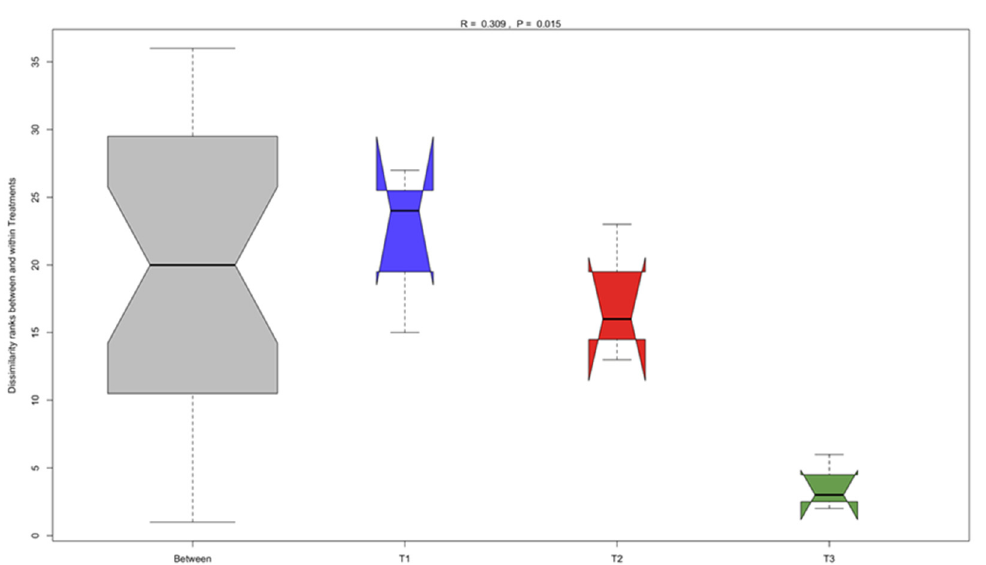
Figure 4. ANOSIM showing the dissimilarity between